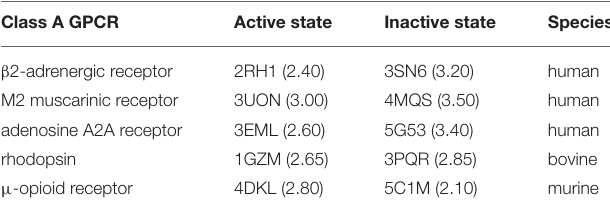
TABLE 4 | Active/inactive pairs of mammalian class A GPCR crystal structures used for the graph-based structural